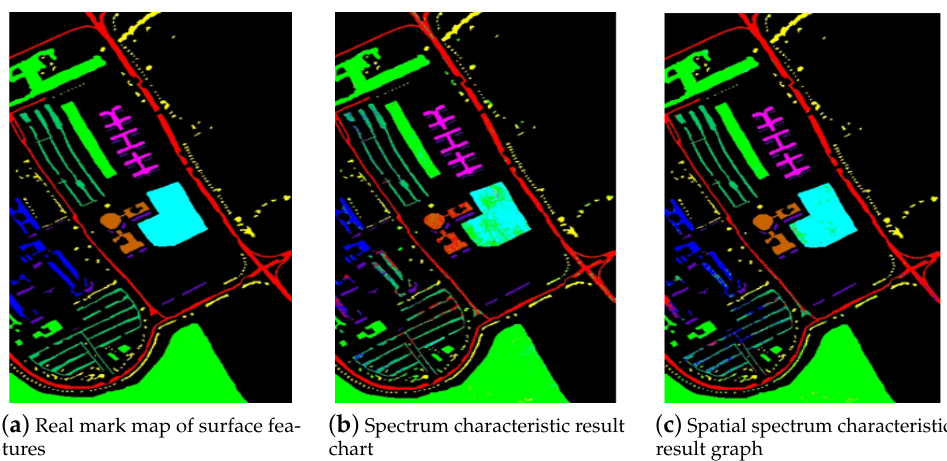
Figure 9. Classification results of Pavia University dataset.